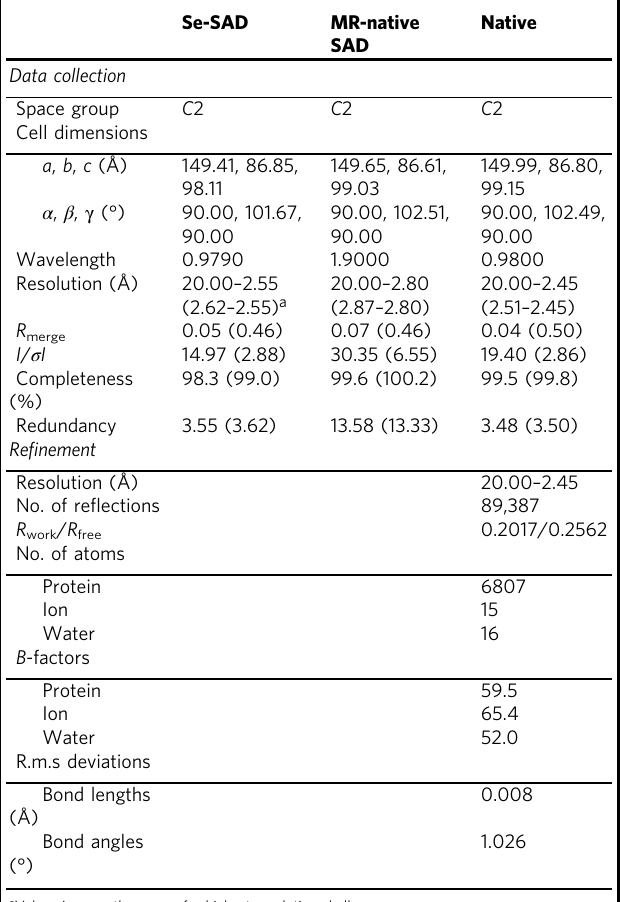
Table 1 Data collection, phasing and re fi nement statistics for the X-ray structure of HIRA(644 –